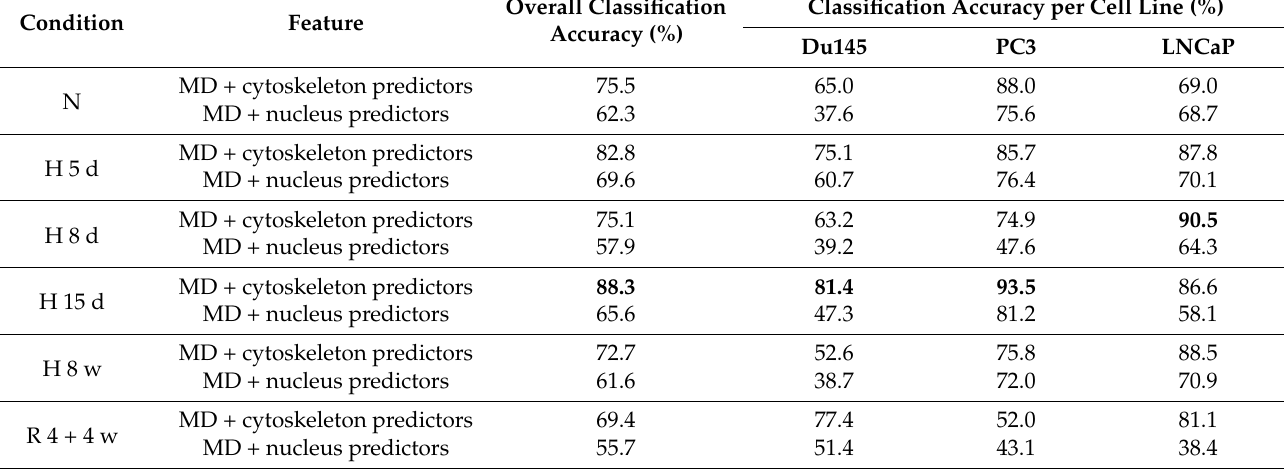
Table 1. Machine-learning classification of Du145, PC3 and LNCaP cell lines based on 15 cytoskeletal and 15 nuclear geometric features (predictors). The different conditions are normoxia (N), acute hypoxia (5 d, 8 d, 15 d—days 5, 8 and 15), chronic hypoxia (8 w—8 weeks) and recovery (4 + 4 w—4 weeks hypoxia + 4 weeks normoxia). Overall classification accuracy and true-positive accuracy of individual cell lines are presented. Highest accuracy is shown in bold. MD—AQP3 mass